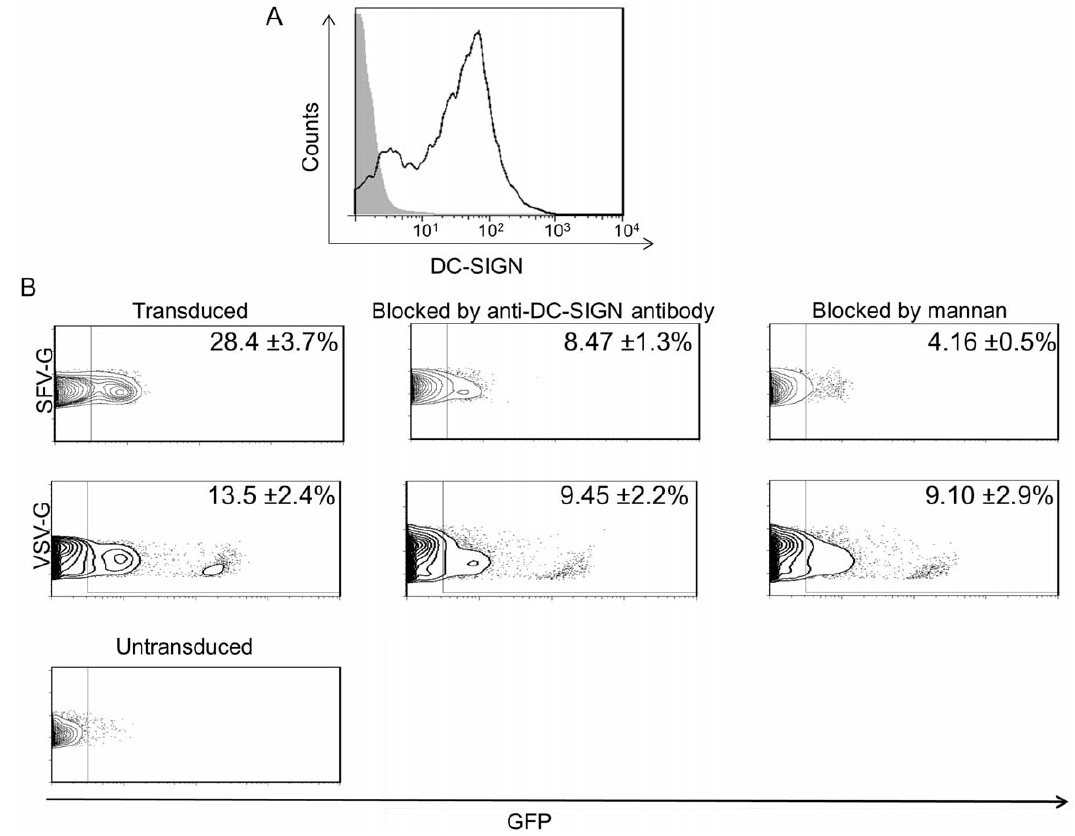
Figure 5. Transduction of MoDCs by lentiviruses is inhibited with anti-DCSIGN antibody and mannan. Human monocyte-derived DCs (MoDCs) were generated by culturing respective precursor cells in the presence of GM-CSF and IL-4. (A) The adherent cells (1 6 10 6 ) were cultured for 2 days and then DC-SIGN expression was detected by flow cytometry. (B) Human MoDCs (1 6 10 6 ) were incubated for 1 hour with mannan (200 m g/ mL), anti-DC-SIGN(R) antibody (20 m g/mL) or without any reagents. The cells were then infected with FUGW/SFVG or FUGW/VSVG (MOI=10) for 8 hours in the presence of blocking reagents. GFP expression was assayed by flow cytometry five days post-transduction where one representative figure is shown with values given as the mean of triplicates 6